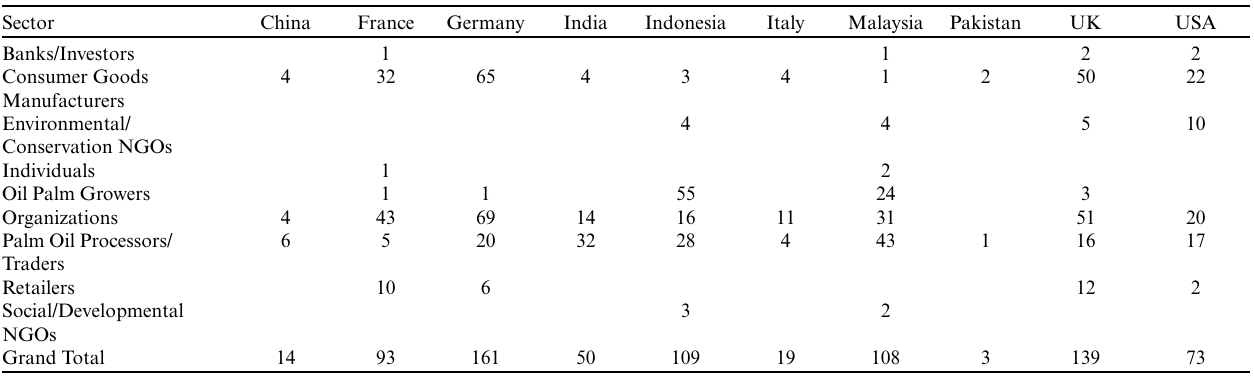
Table 3 . Roundtable on Sustainable Palm Oil members by country and sector (RSPO